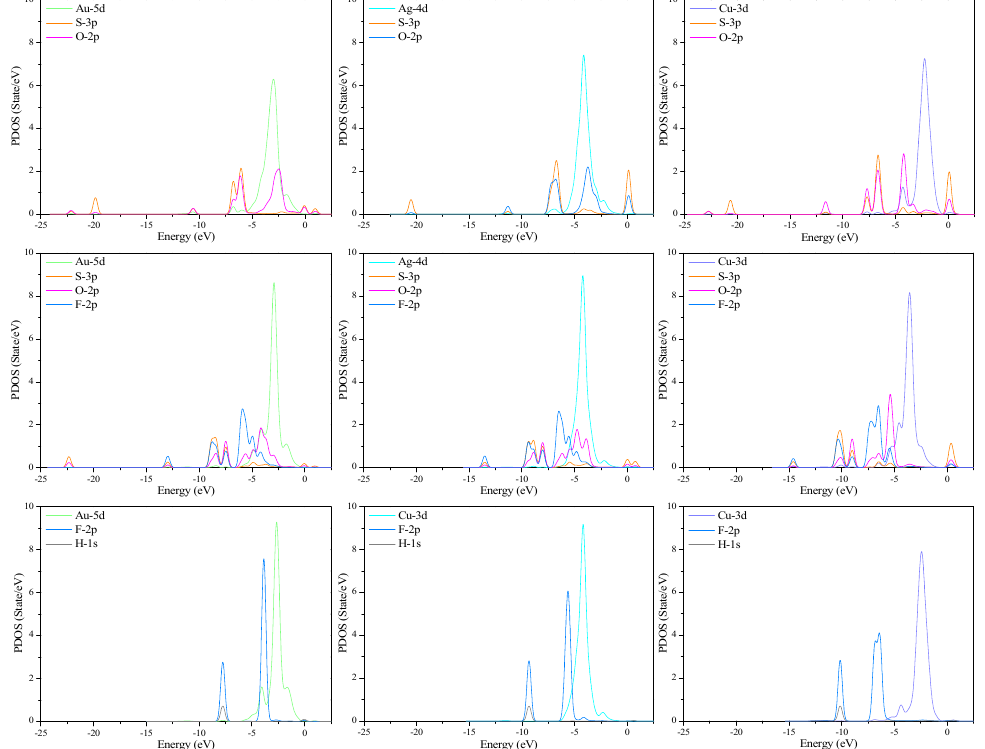
Figure 6. PDOS distribution of SO 2 , SOF 2 , and HF adsorbed TM-MoTe 2 systems.